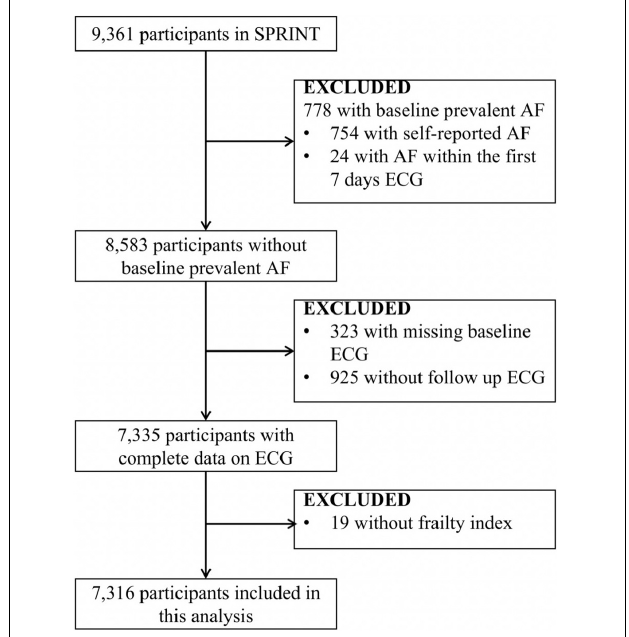
FIGURE 1 | Inclusions and exclusions of the participants included in the analysis. AF indicates atrial fibrillation/flutter. SPRINT, Systolic Blood Pressure Intervention